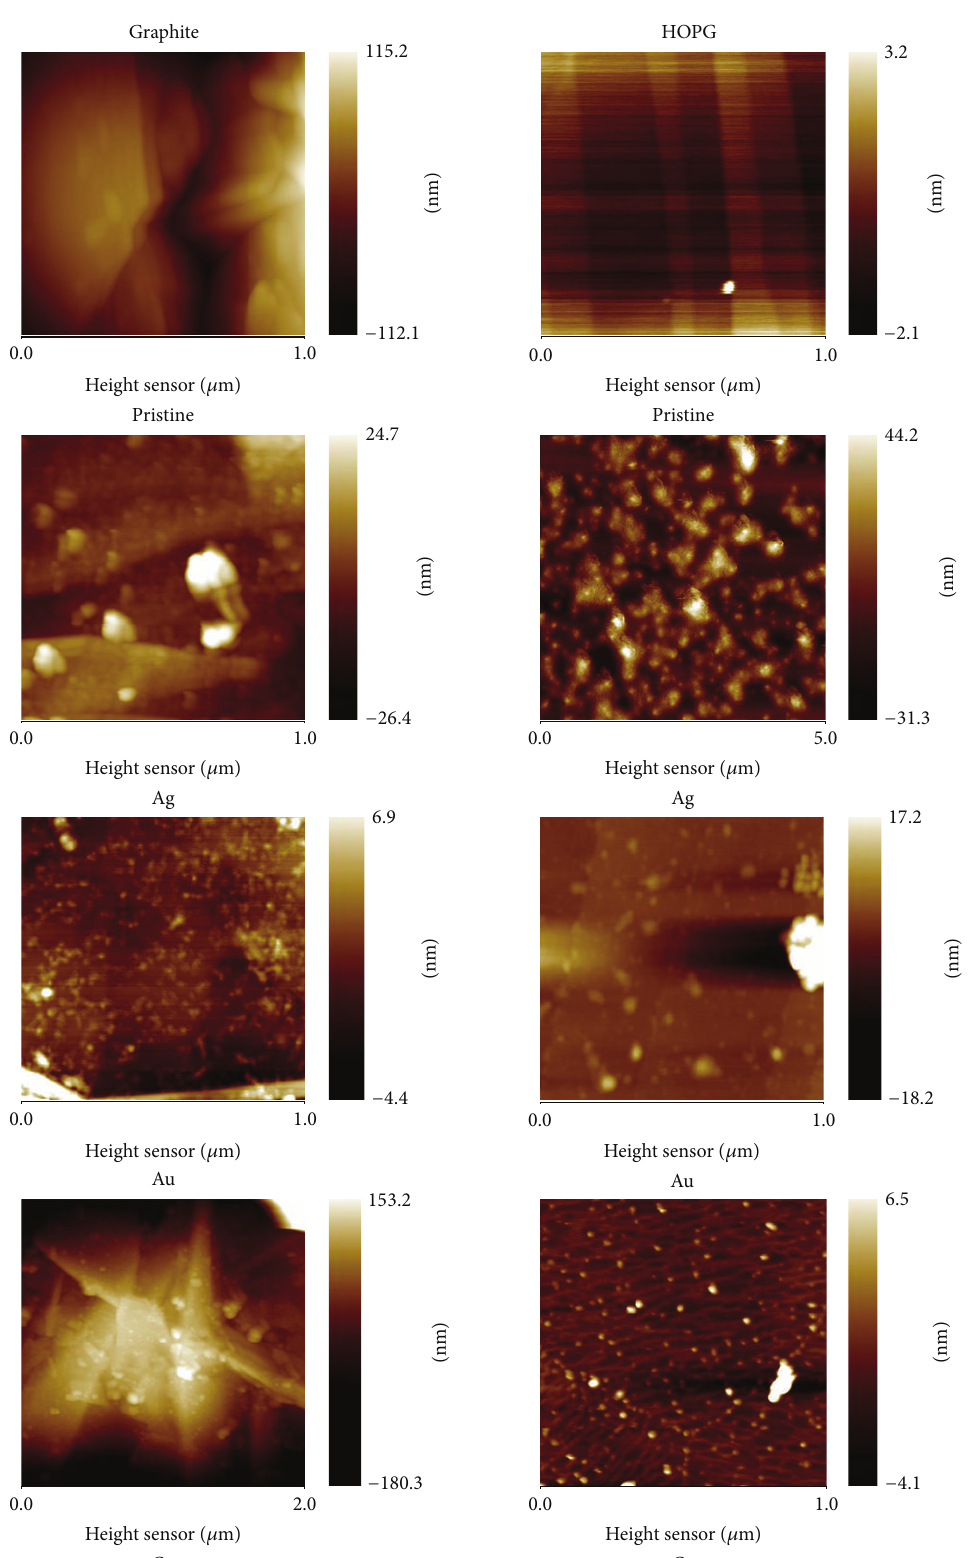
Figure 1: AFM images for pristine amorphous and orientated graphite. The label under each image indicates the metal